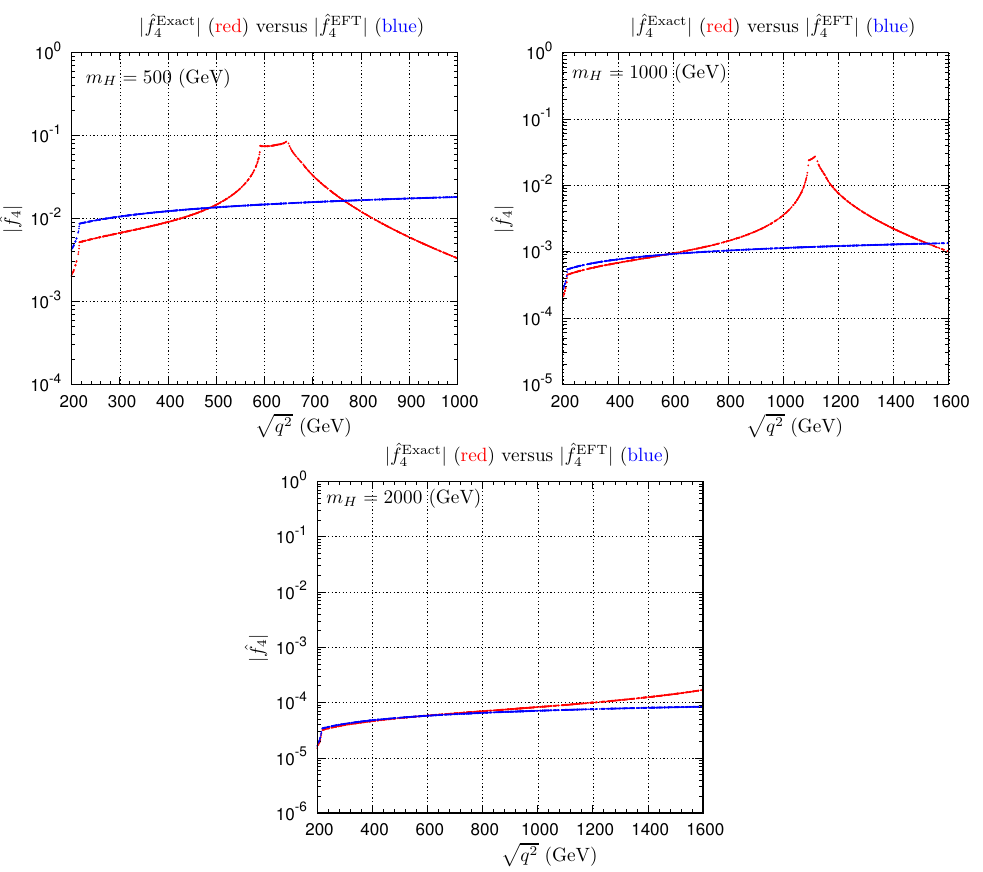
Figure 5 . Red: the normalized form factor ^ f Z ( q 2 ) as de(cid:12)ned in eq. (4.10). We show the dependence 4 on q 2 for 3 di(cid:11)erent values m H of the second neutral Higgs mass. The heaviest neutral Higgs mass is assumed to be m 2 + v 2 . Blue: the same observable calculated in the matched SMEFT p H (cf. eq. (5.1) in section p